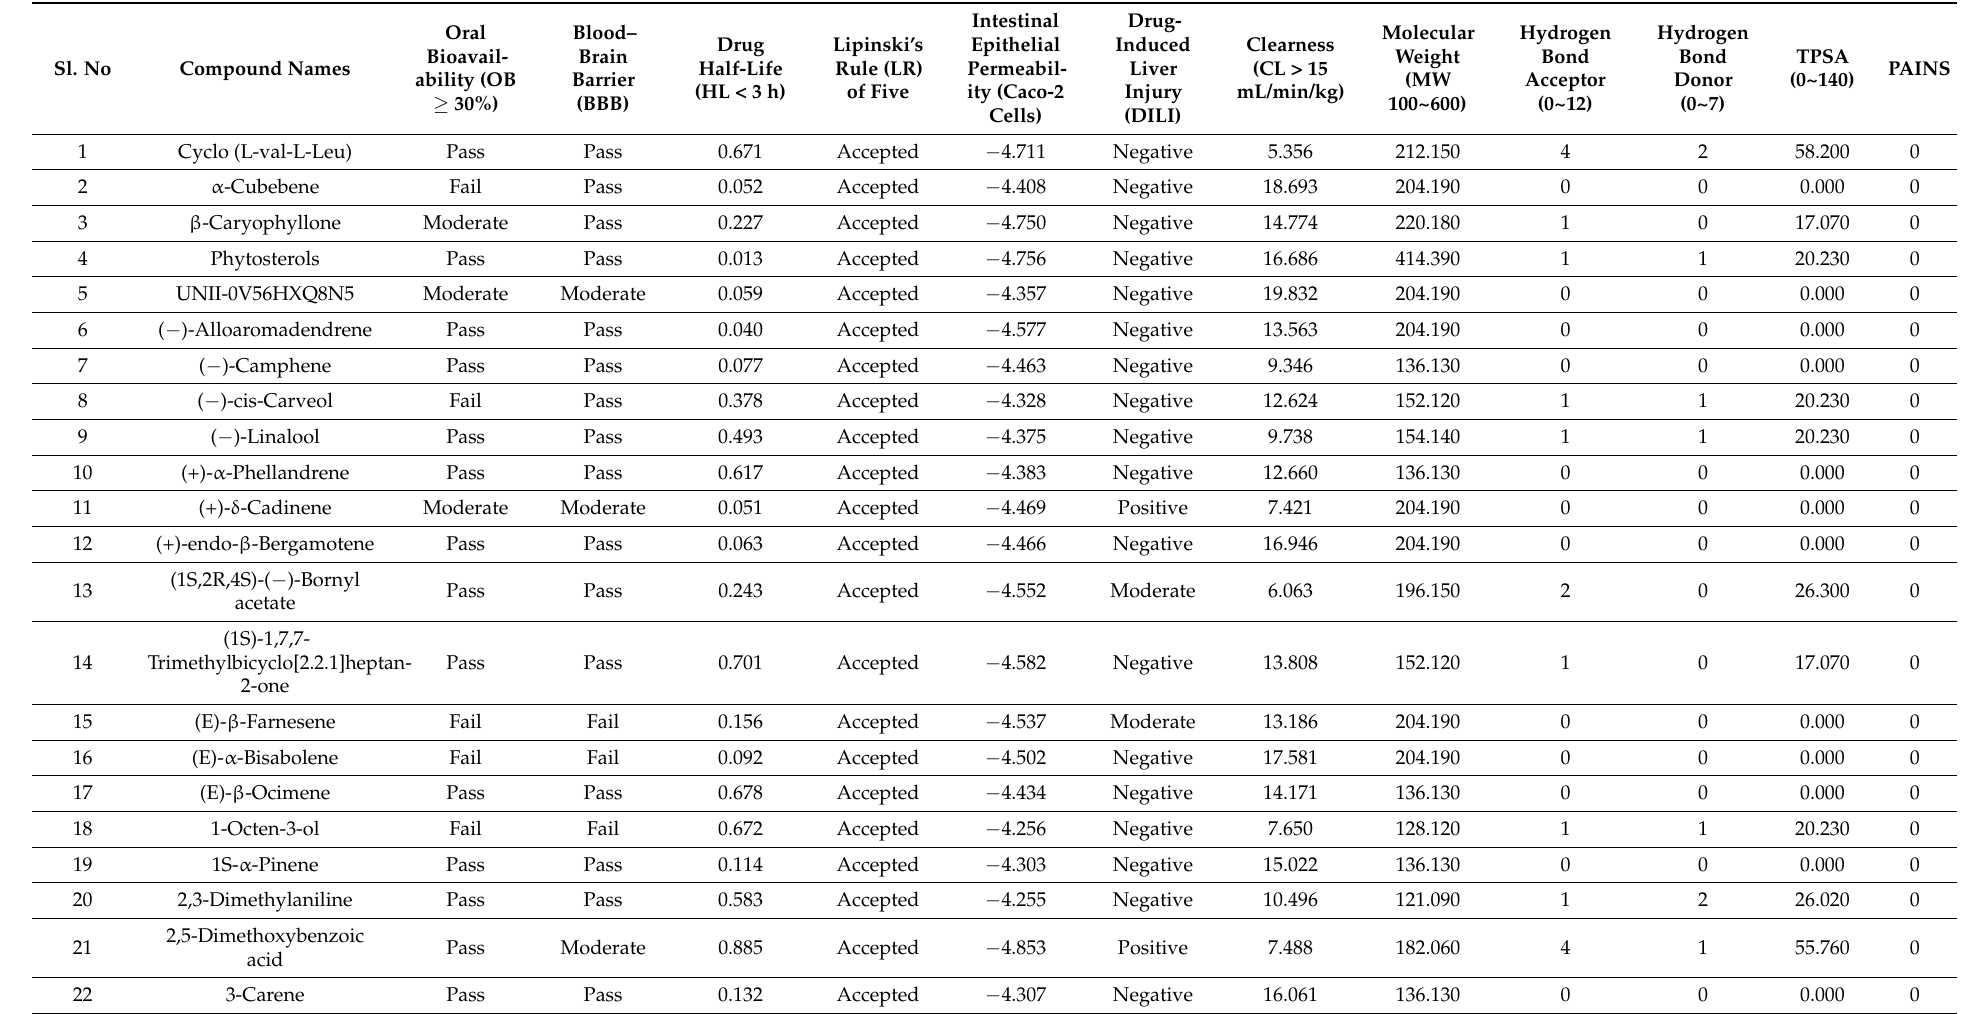
Table 1. Screening of active compounds using ADMET